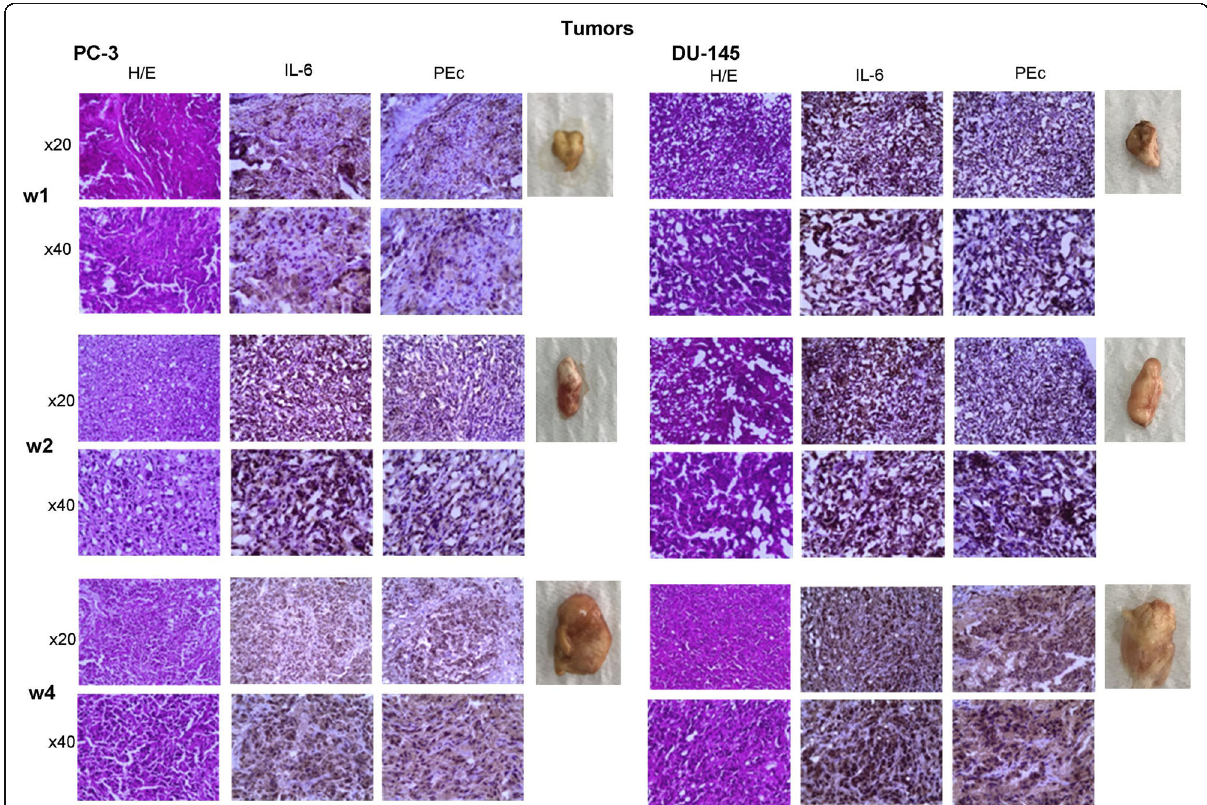
Fig. 4 Immunohistochemical detection of IL-6 and PEc in prostate tumors in SCID mice. IL-6 and PEc present proportional expression levels that increase as tumors progress. IL-6 is mainly expressed from cancer cells rather than infiltrating cells of the IR. W1, w2, w4 stands for week 1, 2, 4 after tumor detection by palpitation. ( n = 3 mice per case were